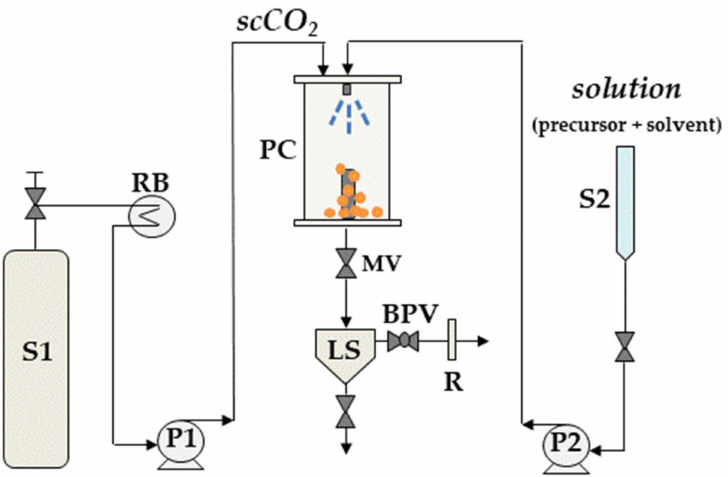
Figure 2. A schematic representation of a generic SAS process. P1, P2: pumps; S1: CO 2 supply; S2: liquid solution supply; RB: refrigerating bath; PC: precipitation chamber; LS: liquid separator; MV: micrometric valve; BPV: back-pressure valve; R: